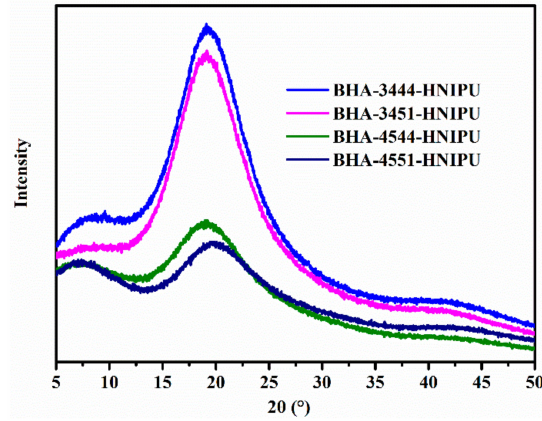
Figure 13. XRD pattern of